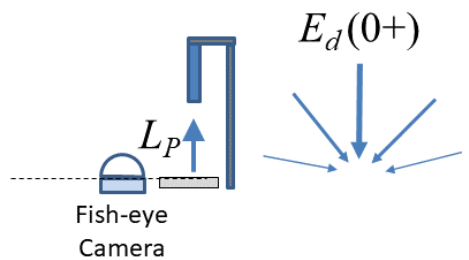
Figure 7. Location of fish-eye camera used for qualitative checking of shading of reflectance plaque, for comparison with Figure 4 for the direct measurement of 𝑬 𝒅𝟎+ using an irradiance sensor, as described in Section 2.